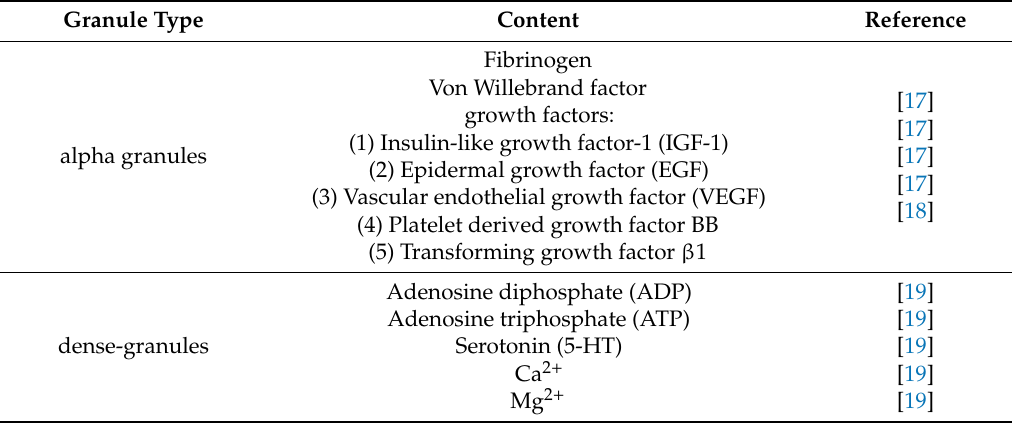
Table 1. Characteristics of canine platelet